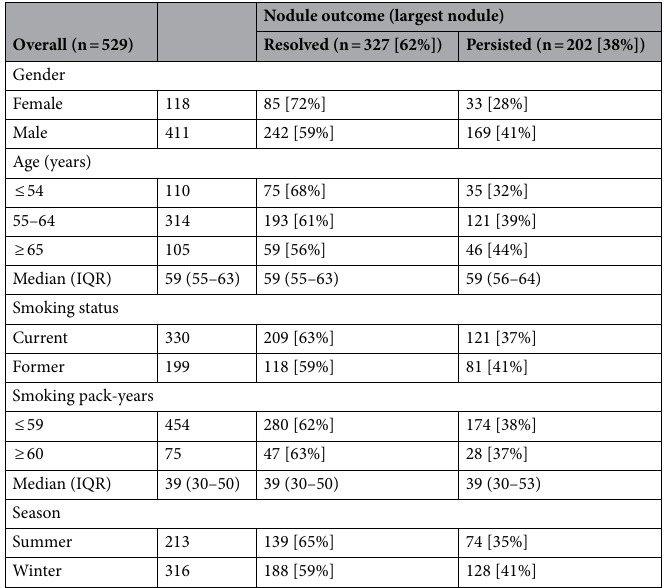
Table 1. Characteristics of participants with ≥ 1 resolving or persisting new nodule reported during screening rounds two and three of the NELSON trial, including distribution based on nodule outcome (resolving versus persisting). N total number of participants with ≥ 1 new lung nodule, IQR Inter quartile range. Summer (Hay fever season) was defined as 1st April to 30th September, and winter (Influenza season) as 1st October to 31st March.